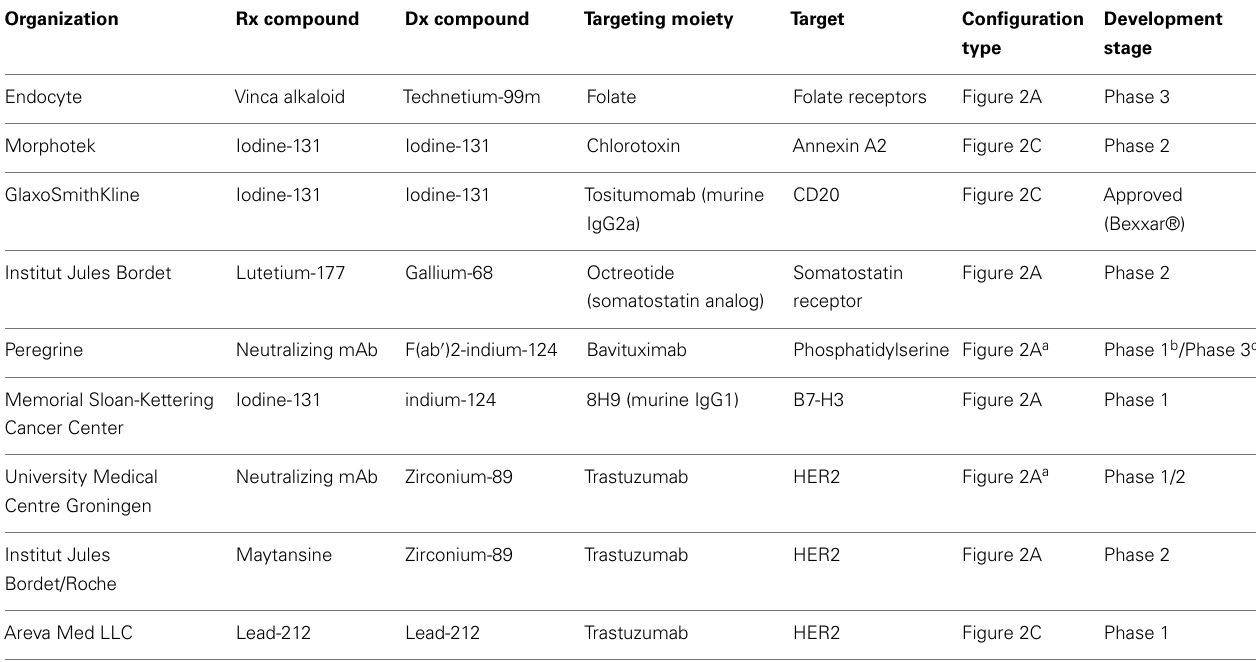
Table 6 | Clinical stage theranostics